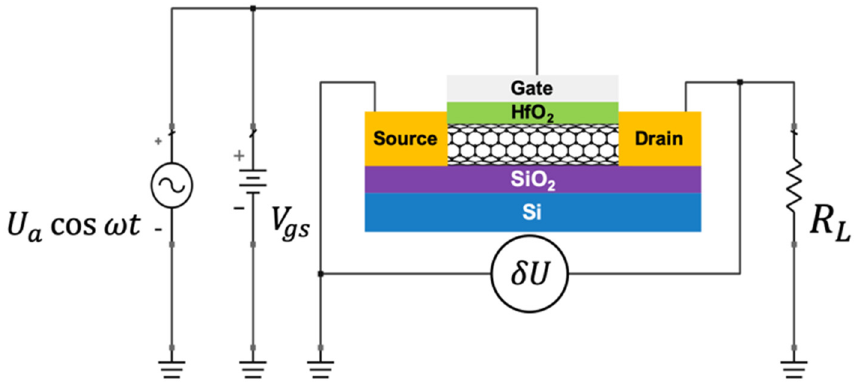
Figure 3. Schematic illustration of the simulation circuit for the CNTFET THz detection with the open boundary condition at the drain.